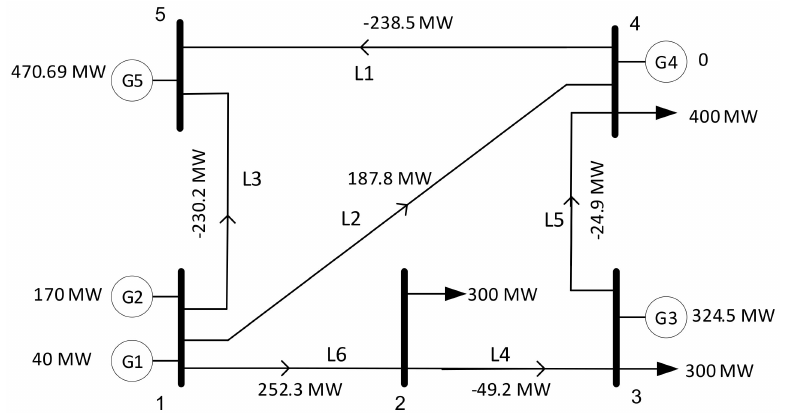
Figure 5. Illustration of power flows in the test system.